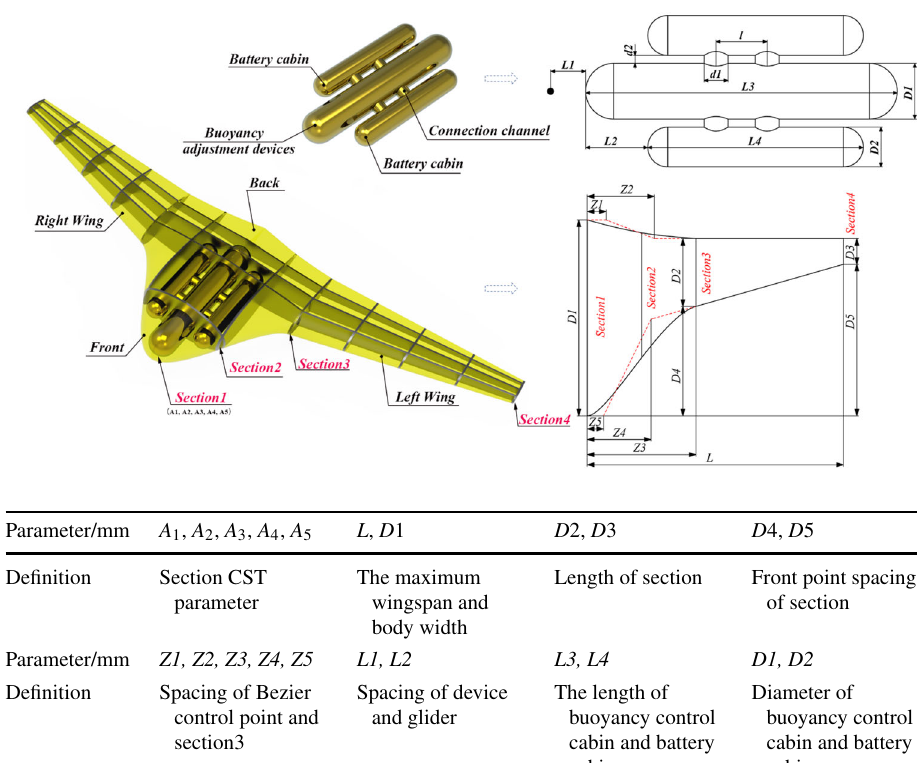
Fig. 16 The shape and layout of the BWBUG parameter diagram